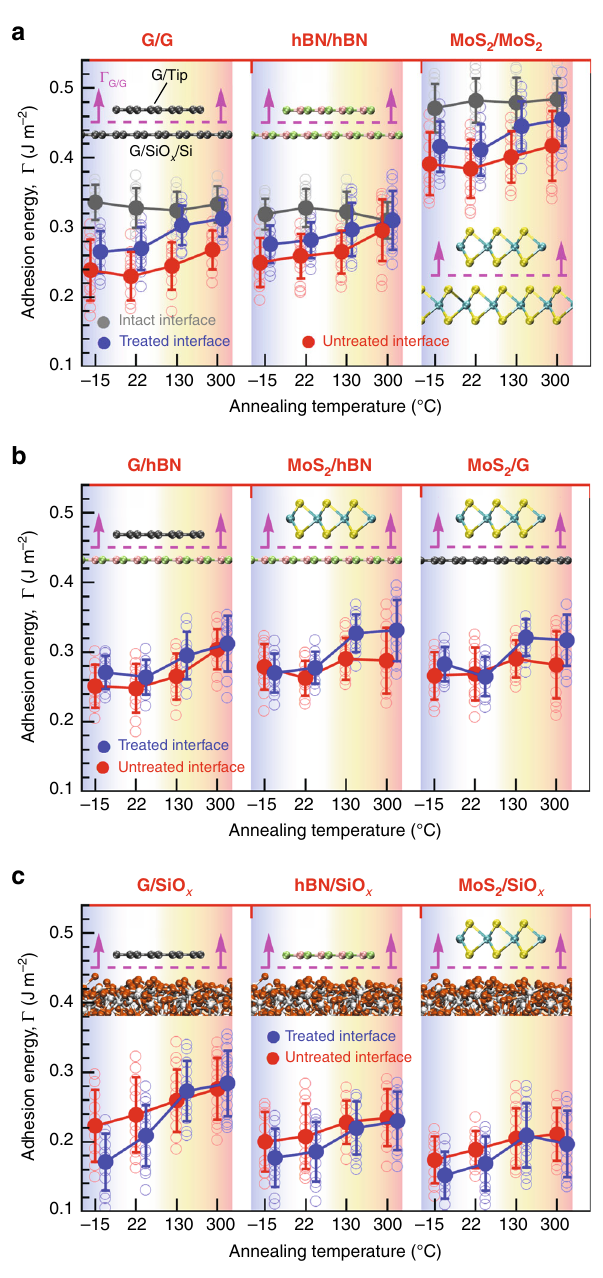
Fig. 2 Interfacial adhesion energy measurements. IAE values as a function of annealing temperatures at the a G, hBN, and MoS 2 homointerfaces; b G/ hBN, MoS 2 /hBN, and MoS 2 /G heterointerfaces; and c G/SiO x , hBN/SiO x , and MoS 2 /SiO x heterointerfaces using normal force microscopy technique. Filled gray circles in a denote the intrinsic IAE values at the intact G, hBN, and MoS 2 homointerfaces, whereas fi lled blue (red) circles in a – c denote the IAE values between 2D crystal tips and precooling-treated (untreated) substrates. Each open transparent gray circle in a represents a single IAE measurement at the intact homointerfaces, whereas each data point shown in open transparent blue and red circles in a , b represents the IAE of the tips on an individual 2D crystal fl ake averaged over ten measurements from different locations of the fl ake surface. Similarly, each data point shown in open transparent blue and red circles in c represents the average IAE value obtained from 10 measurements within an individual small region (1 μ m × 1 μ m) of SiO x substrate. Each fi lled circle in a – c is presented as average of all corresponding open circles± standard deviation. Insets in a – c illustrate ball- and-stick representation of various tip/substrate interfaces where carbon, boron, nitrogen, molybdenum, sulfur, silicon, and oxygen atoms are shown in gray, green, pink, cyan, yellow, white, and